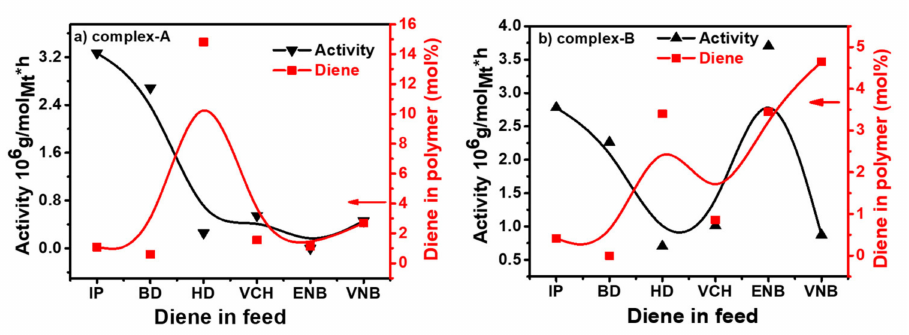
Figure 3. Variation of activity profile and diene content in ethylene/diene in copolymer with ( a ) complex A and ( b ) complex